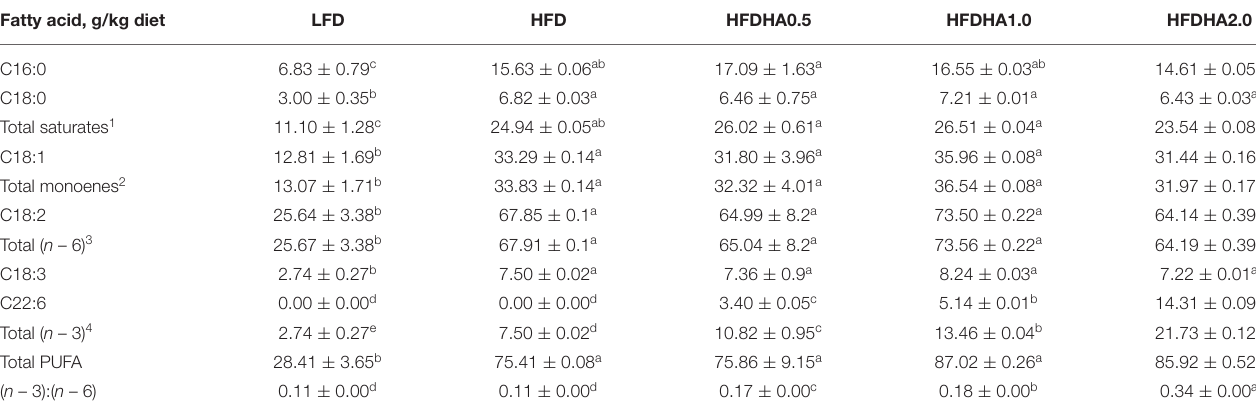
TABLE 2 | Fatty acid compositions of the five diets in 1-month-old zebrafish (g/kg). Fatty acid, g/kg diet LFD HFD HFDHA0.5 HFDHA1.0 HFDHA2.0